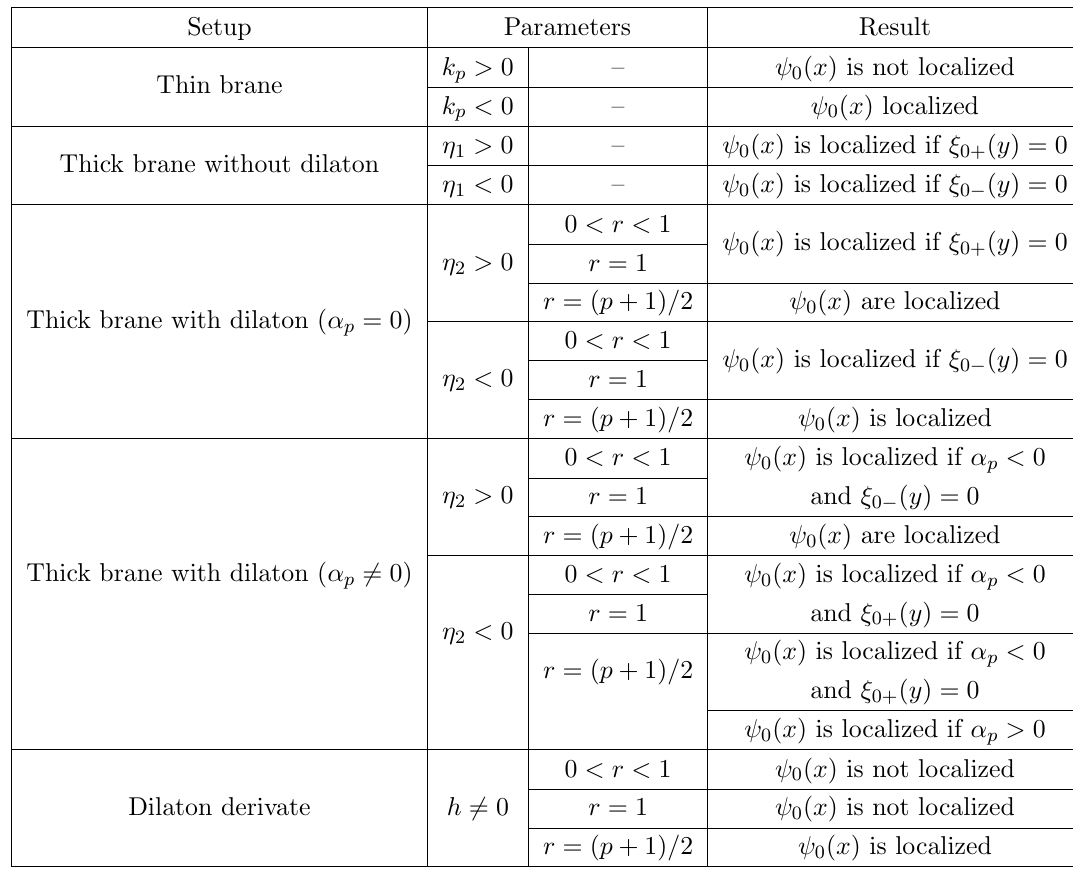
Table 7 . Summary of results of zero mode fermions localization in even dimensions. The 0 ( x ) is the Dirac spinor on the